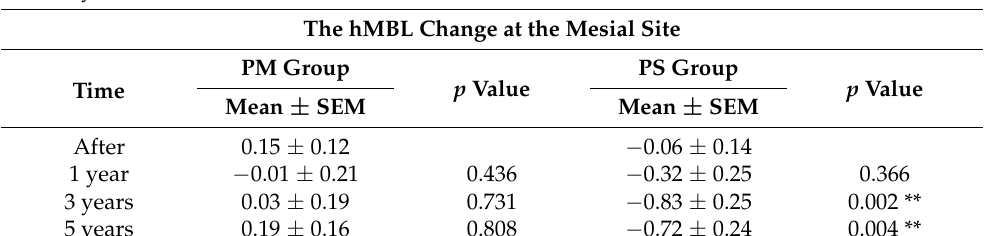
Table 6. Mean r-BIIC percentage of the PM and PS groups.